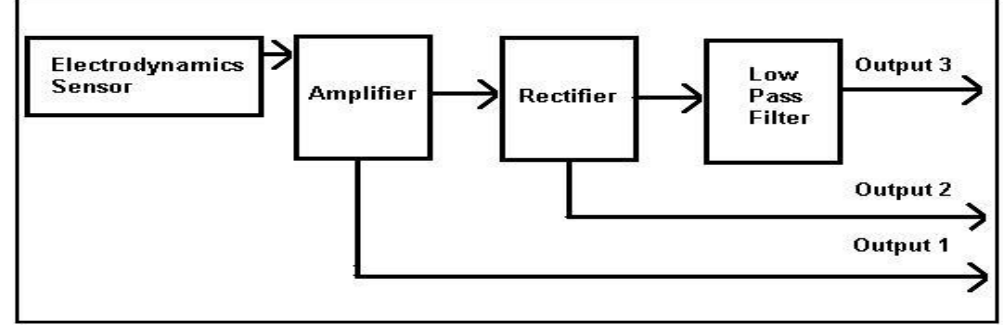
Figure 3. A block diagram of an electrodynamics sensor conditioning circuits.